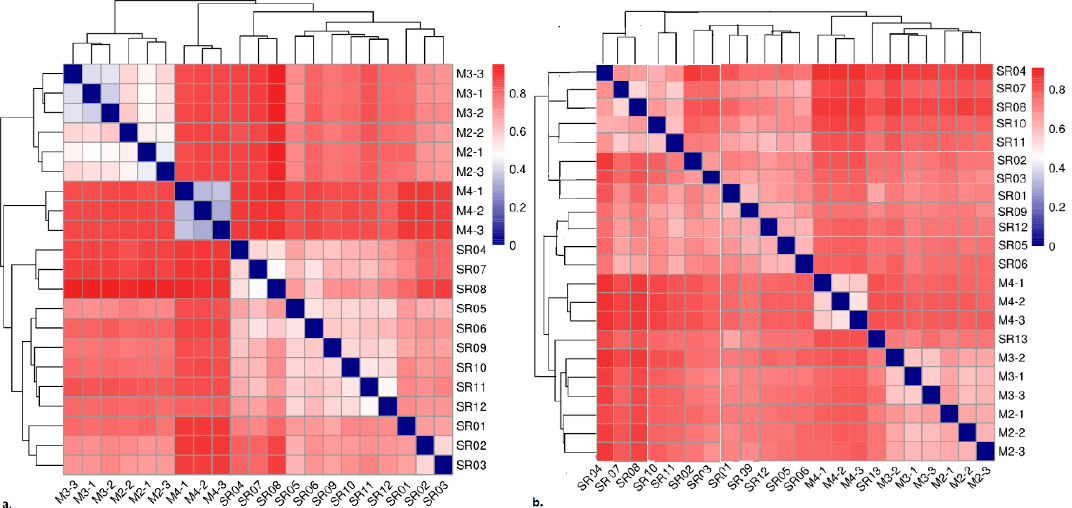
Figure 3. Jaccard similarity analysis based on OTUs at different sampling sites: ( a ) prokaryotic community; ( b ) eukaryotic community. Color bar and clustering tree indicates similarity among ß-diversity at different sampling sites; the similarity was calculated by Euclidean distance and furthest distance between groups.